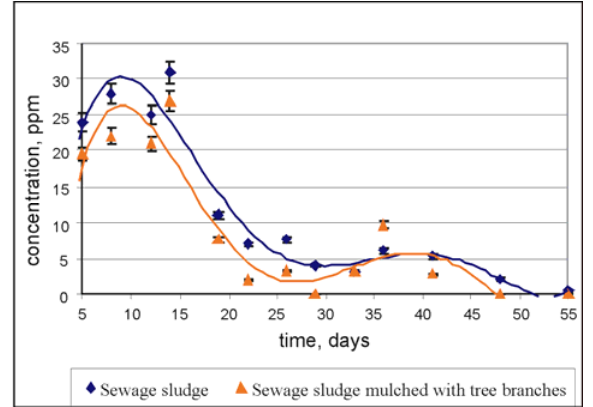
Fig. 15. Hydrogen sulphide emissions during composting of sewage sludge with minor branches